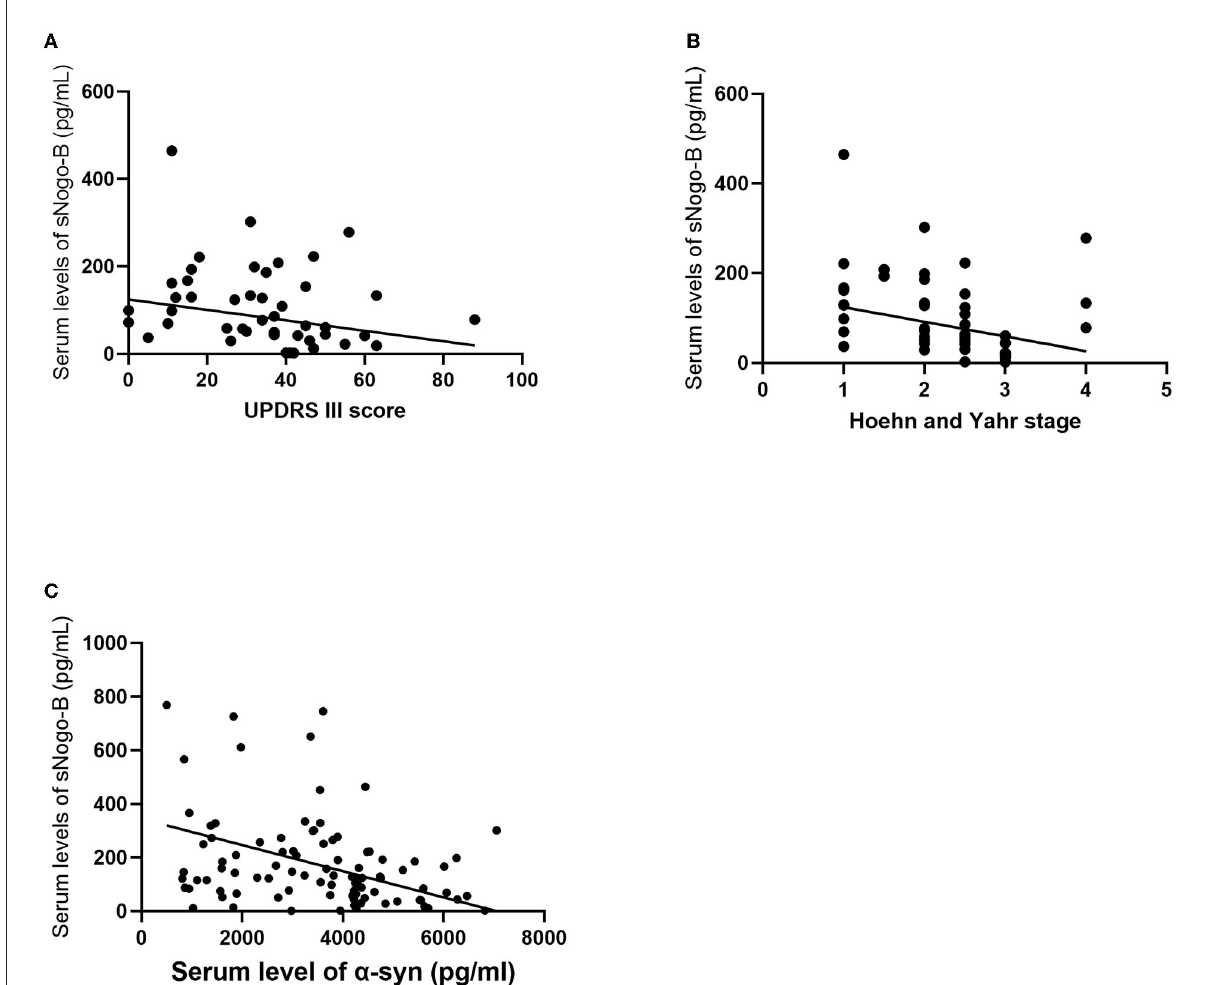
FIGURE3 Correlations analysis of serum sNogo-B and clinical characteristics. (A) Serum sNogo-B level negatively correlated with UPDRS III score ( r = − 0.264, p = 0.049); (B) Serum sNogo-B level negatively correlated with Hoehn and Yahr stage ( r = − 0.344, p = 0.0108); (C) Serum sNogo-B level negatively correlated with serum α -Syn level ( r = − 0.365, p =